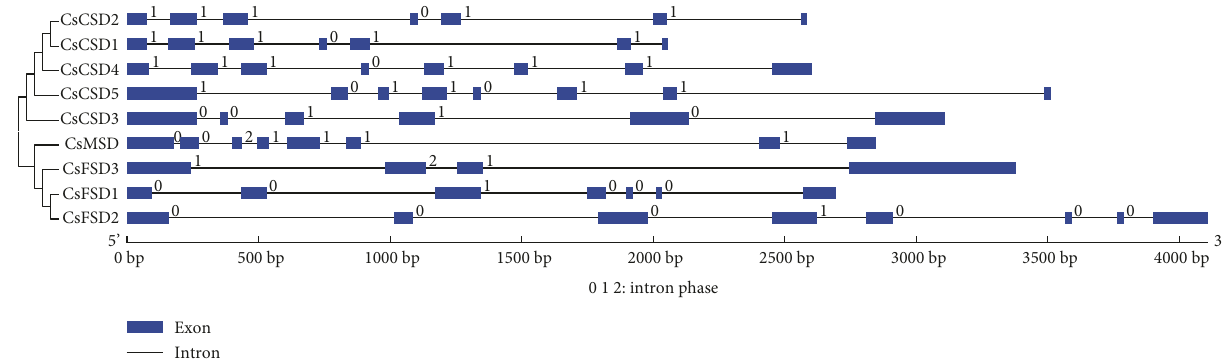
Figure 4: Exon-intron structures of CsSOD genes based on the phylogenetic relationship. Exons and introns are shown as green boxes and thin lines, respectively. Intron phases 0, 1, and 2 are indicated by numbers 0, 1, and